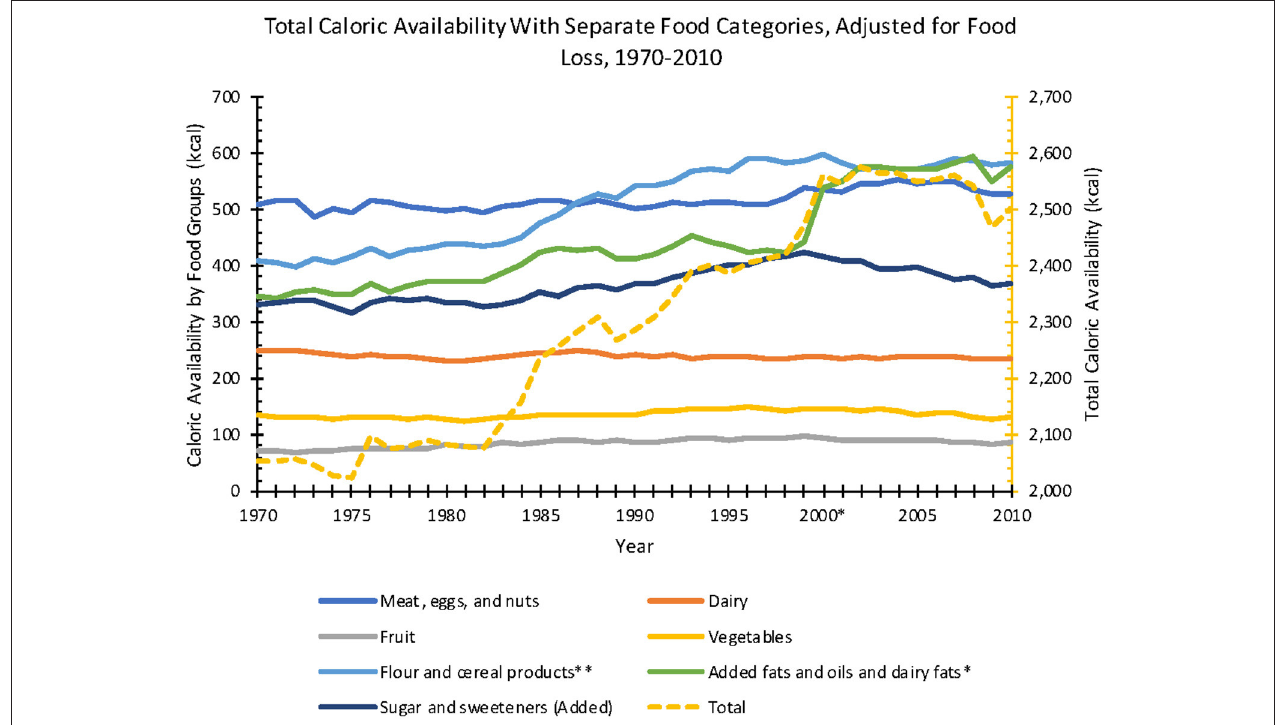
FIGURE 4 | Annual red meat, poultry, and fish and shellfish availability per capita from 1909 to 2019 (Source: USDA ERS ).